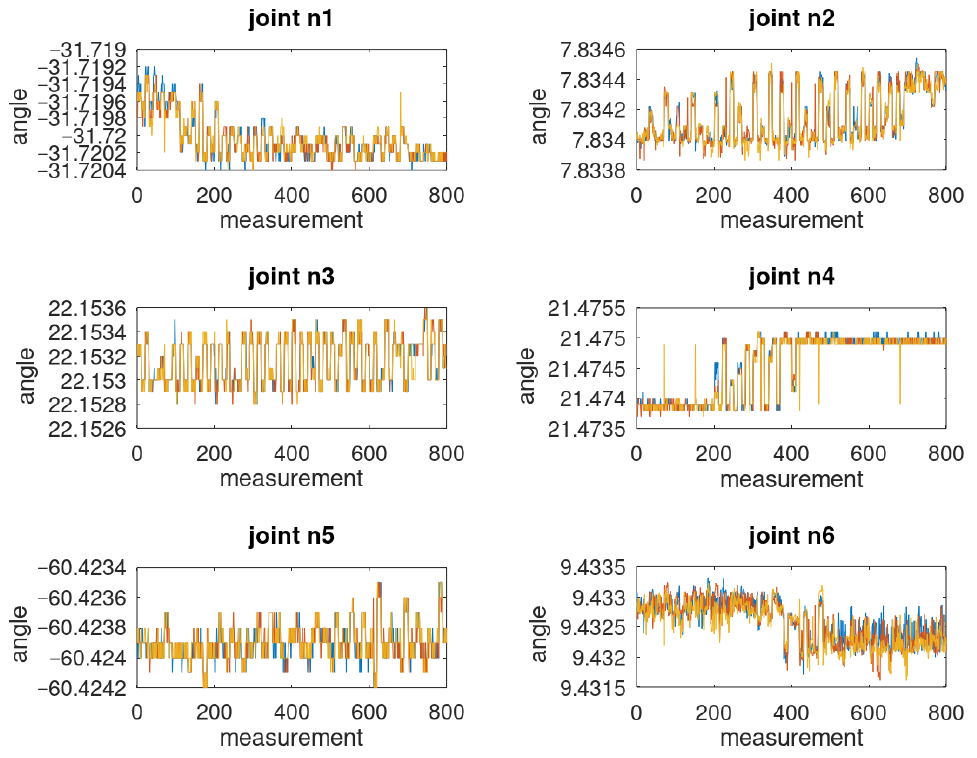
Figure 7. Deviations of joints (°) in the ordered and random selection of default positions.